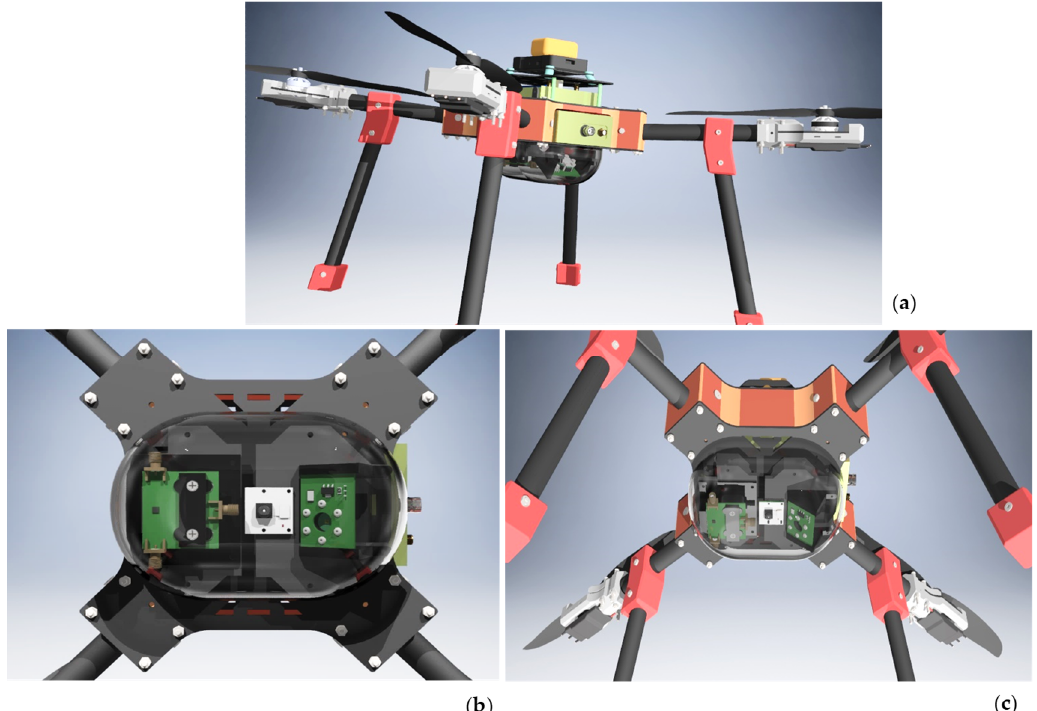
Figure 10. Conceptual design of a drone-based York DF Photon Counting Biosensor. ( a ) Top image shows the full view of the drone-integrated York DF Photon Counting Biosensor with PCS121 electronics, SiPM bias supply and amplifier integrated into the drone body; ( b ) Left image reveals the belly view of the optical elements of the device within dome, including the SiPM, target camera in the center, and excitation LED; ( c ) Right image displays a hovering drone bottom view. Credit: Biosensor integrated drone design by Haktan Ya˘gmur